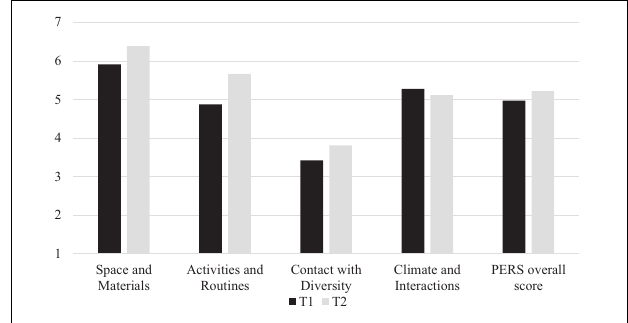
FIGURE 1 | Mean scores for subscales and overall score of the PERS. Data collected 1 month after the playgroups started at T1 and 1 month before their estimated end at T2. n = 12